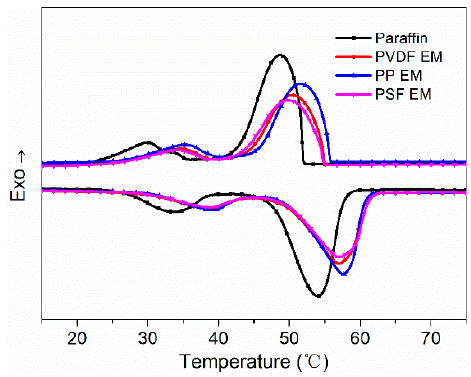
Figure 7. DSC curve of pure paraffin and three encapsulation membranes.